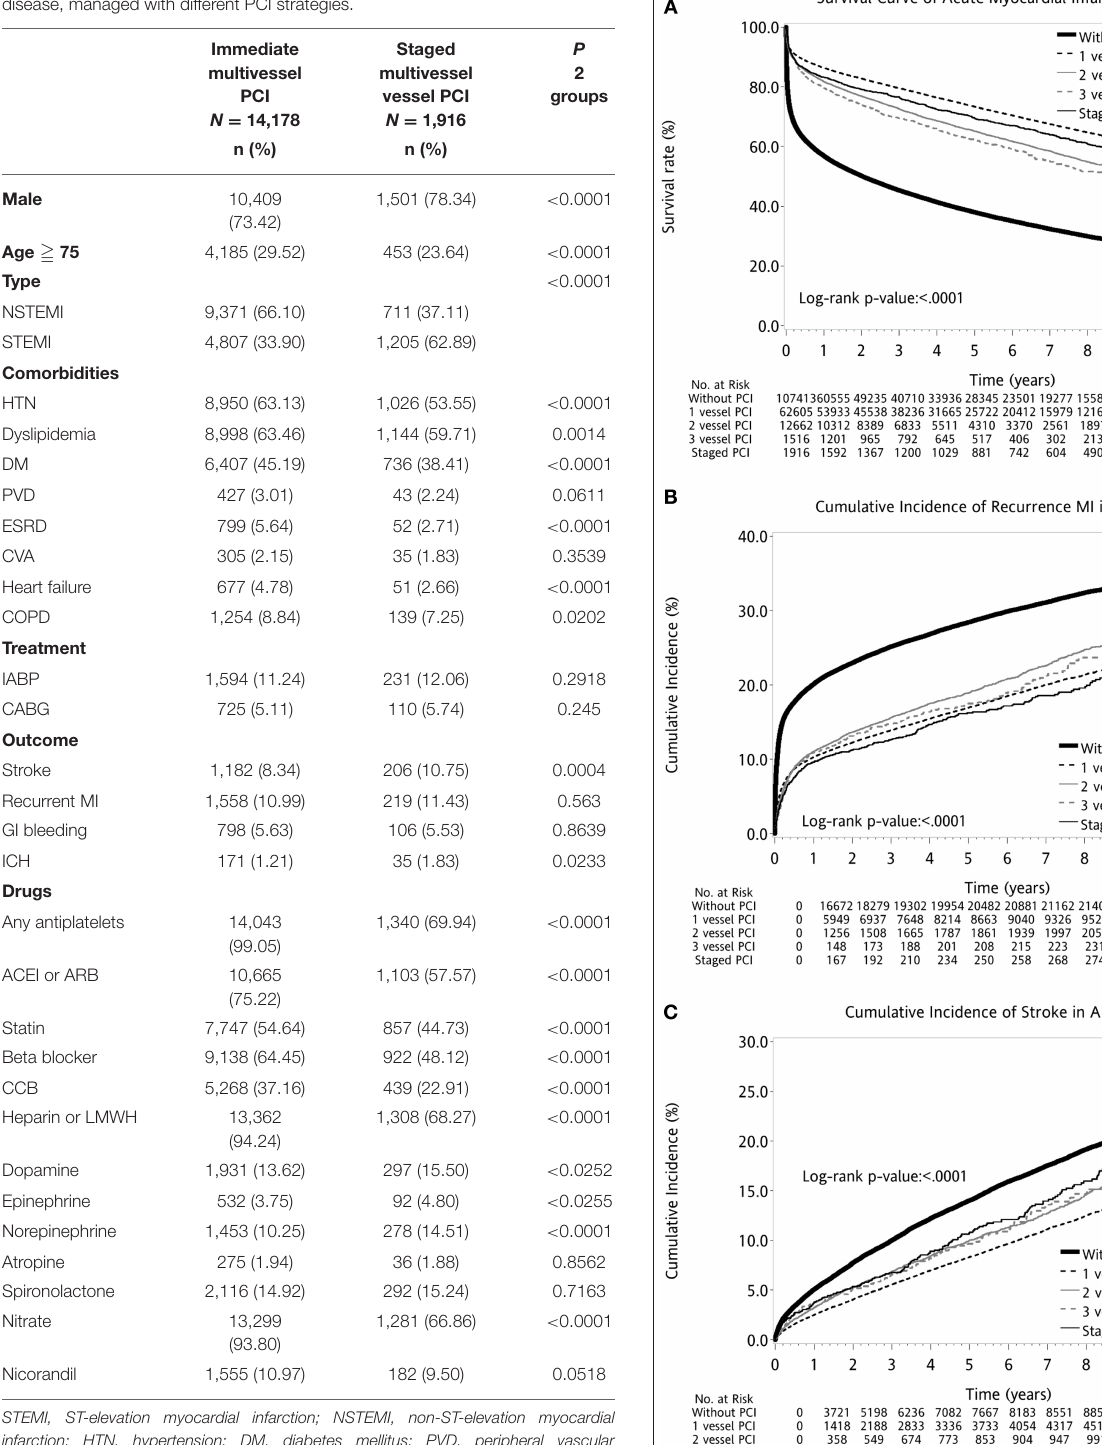
TABLE 2 | Characteristics of hospitalized patients with first AMI and multivessel disease, managed with different PCI strategies.